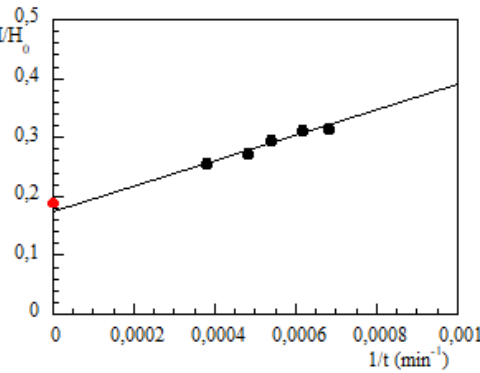
Figure 5. Procedure for extrapolating H ∞ . The red dot represents the value of the normalized height measured after 4 days.